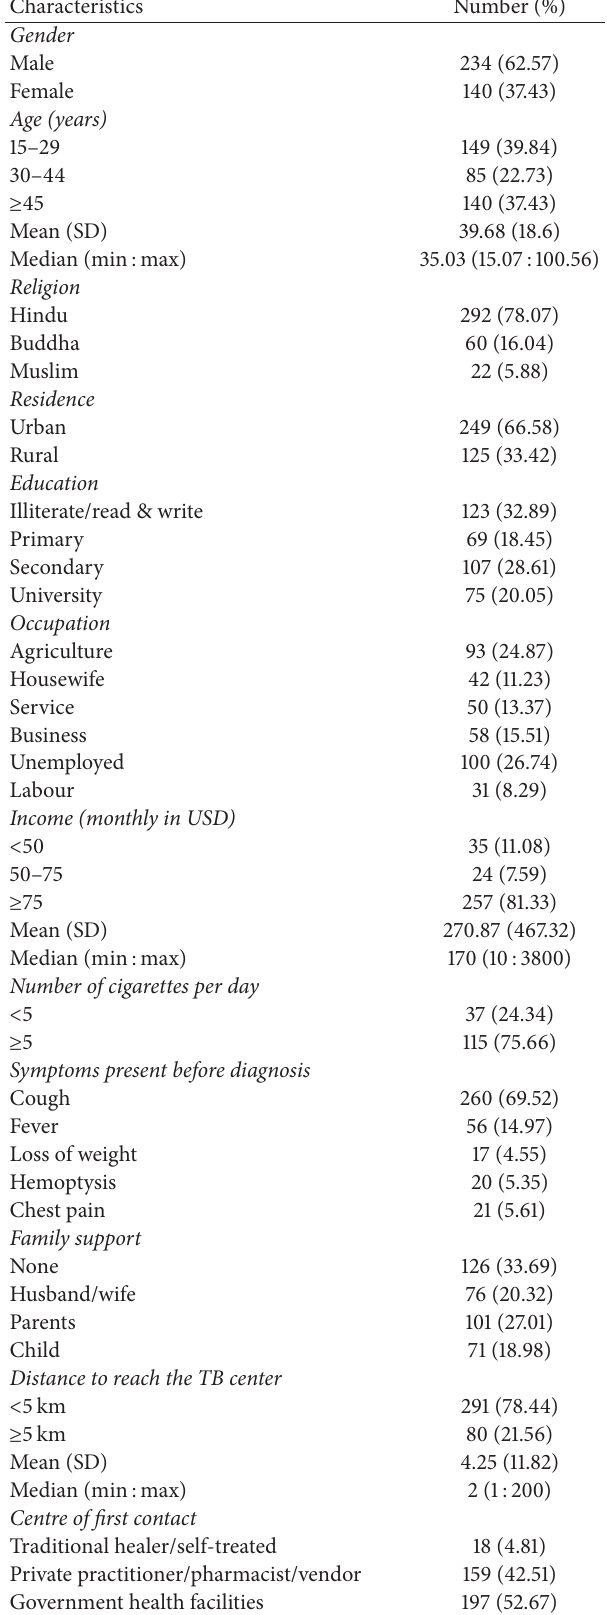
Table 1: Baseline characteristics of